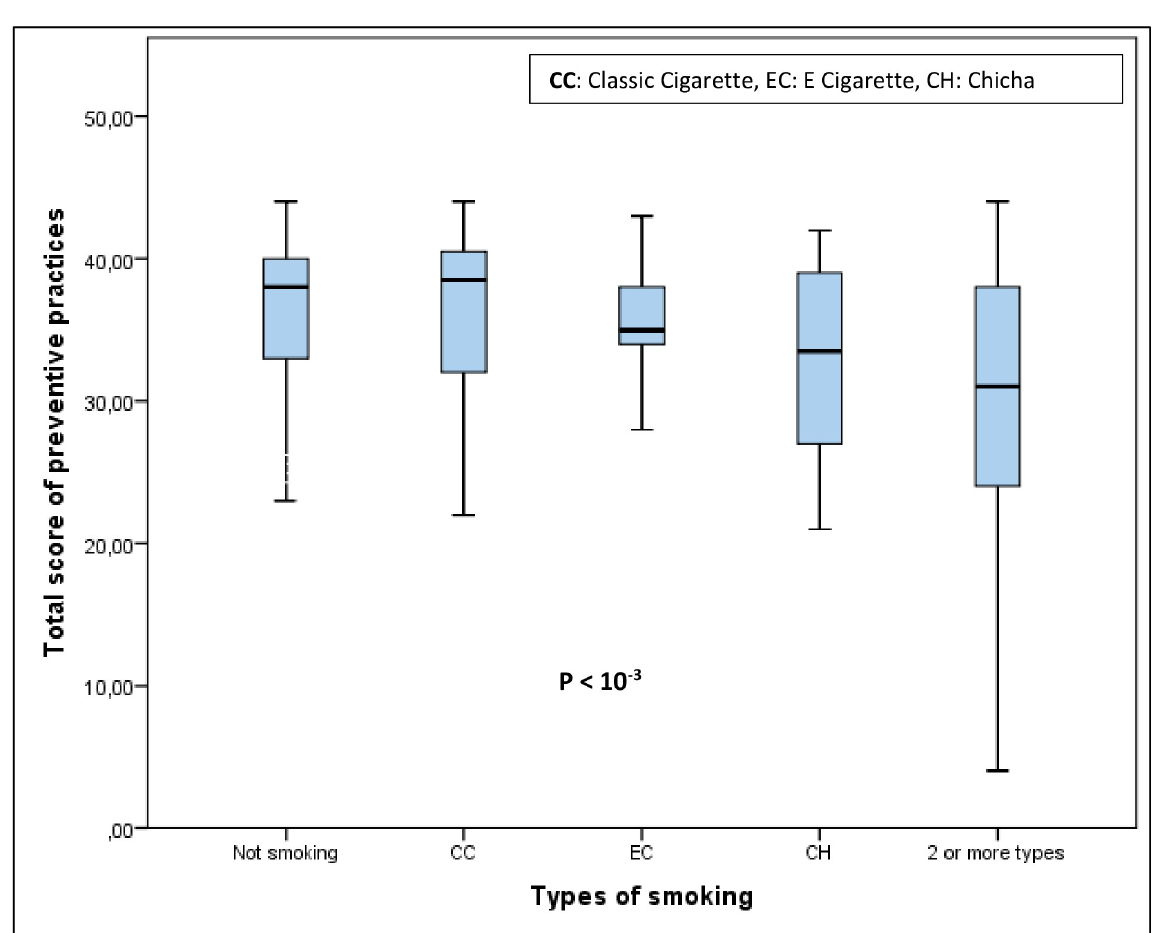
Fig 3. Comparison of the precautionary measures score according to the smoking status.